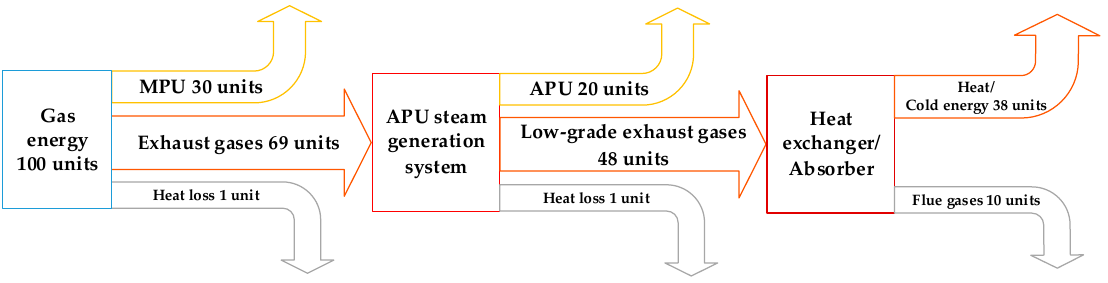
Figure 12. Energy flow chart of the binary energy system.